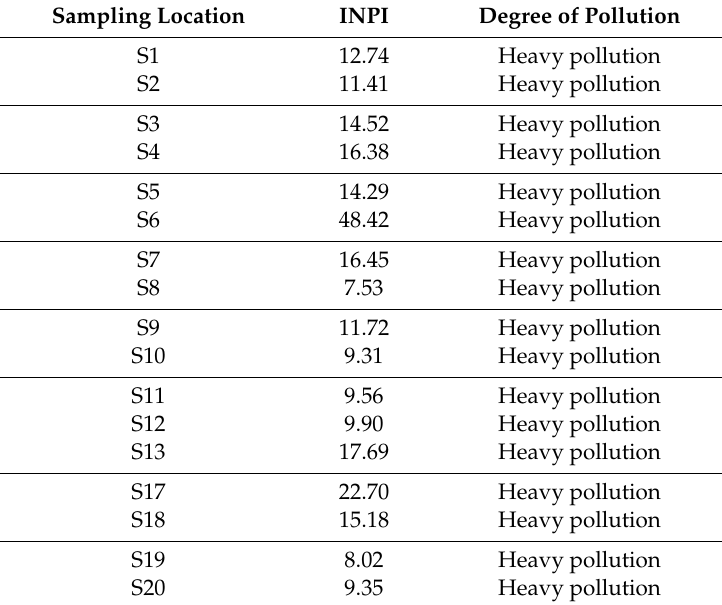
Table 7. The integrated Nemerow pollution index (INPI) of the surface soils at the 17 sampling locations. Sampling Location INPI Degree of